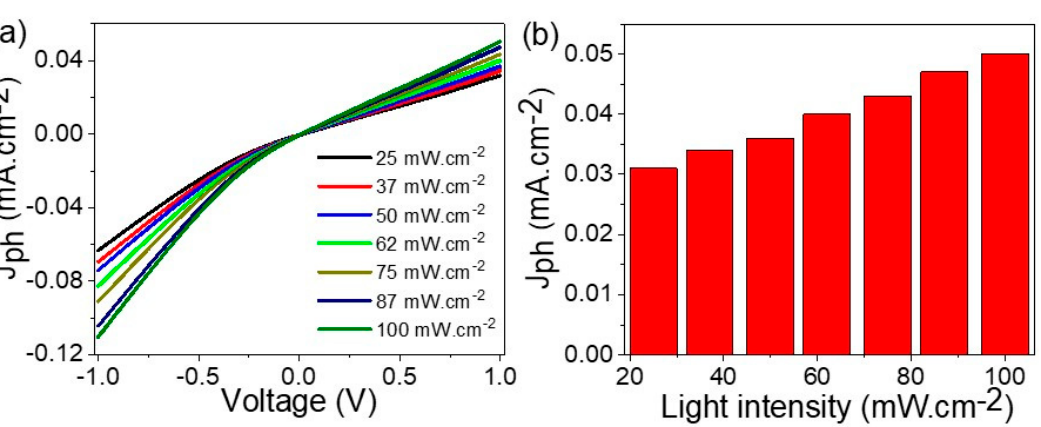
Figure 7. ( a ) The response of the optoelectronic device to different light intensities from 25 to 100 mW·cm − 2 and ( b ) the values of current density with the light intensity at 1.0 V.